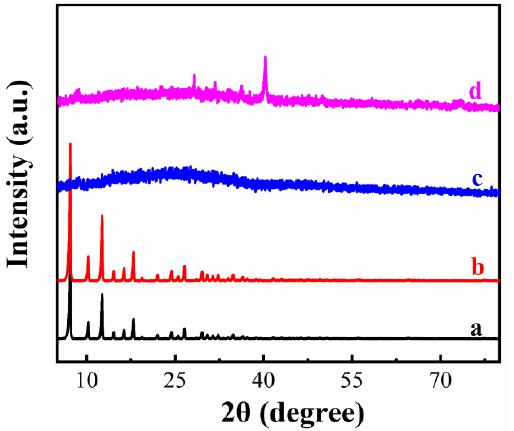
Figure 2. XRD patterns of ZIF-8 ( a ), AuNPs/ZIF-8 ( b ), PCs ( c ), and AuNPs/PCs ( d ).